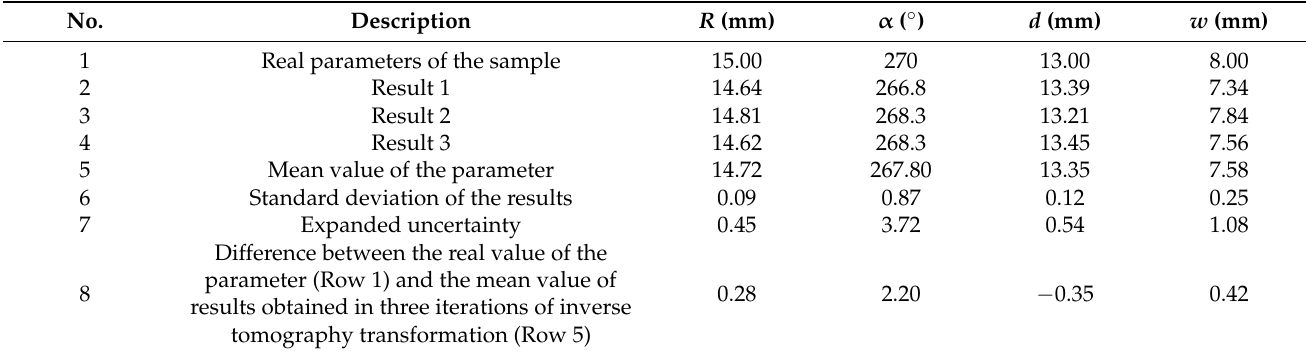
Table 3. Uncertainty analysis of inverse tomography